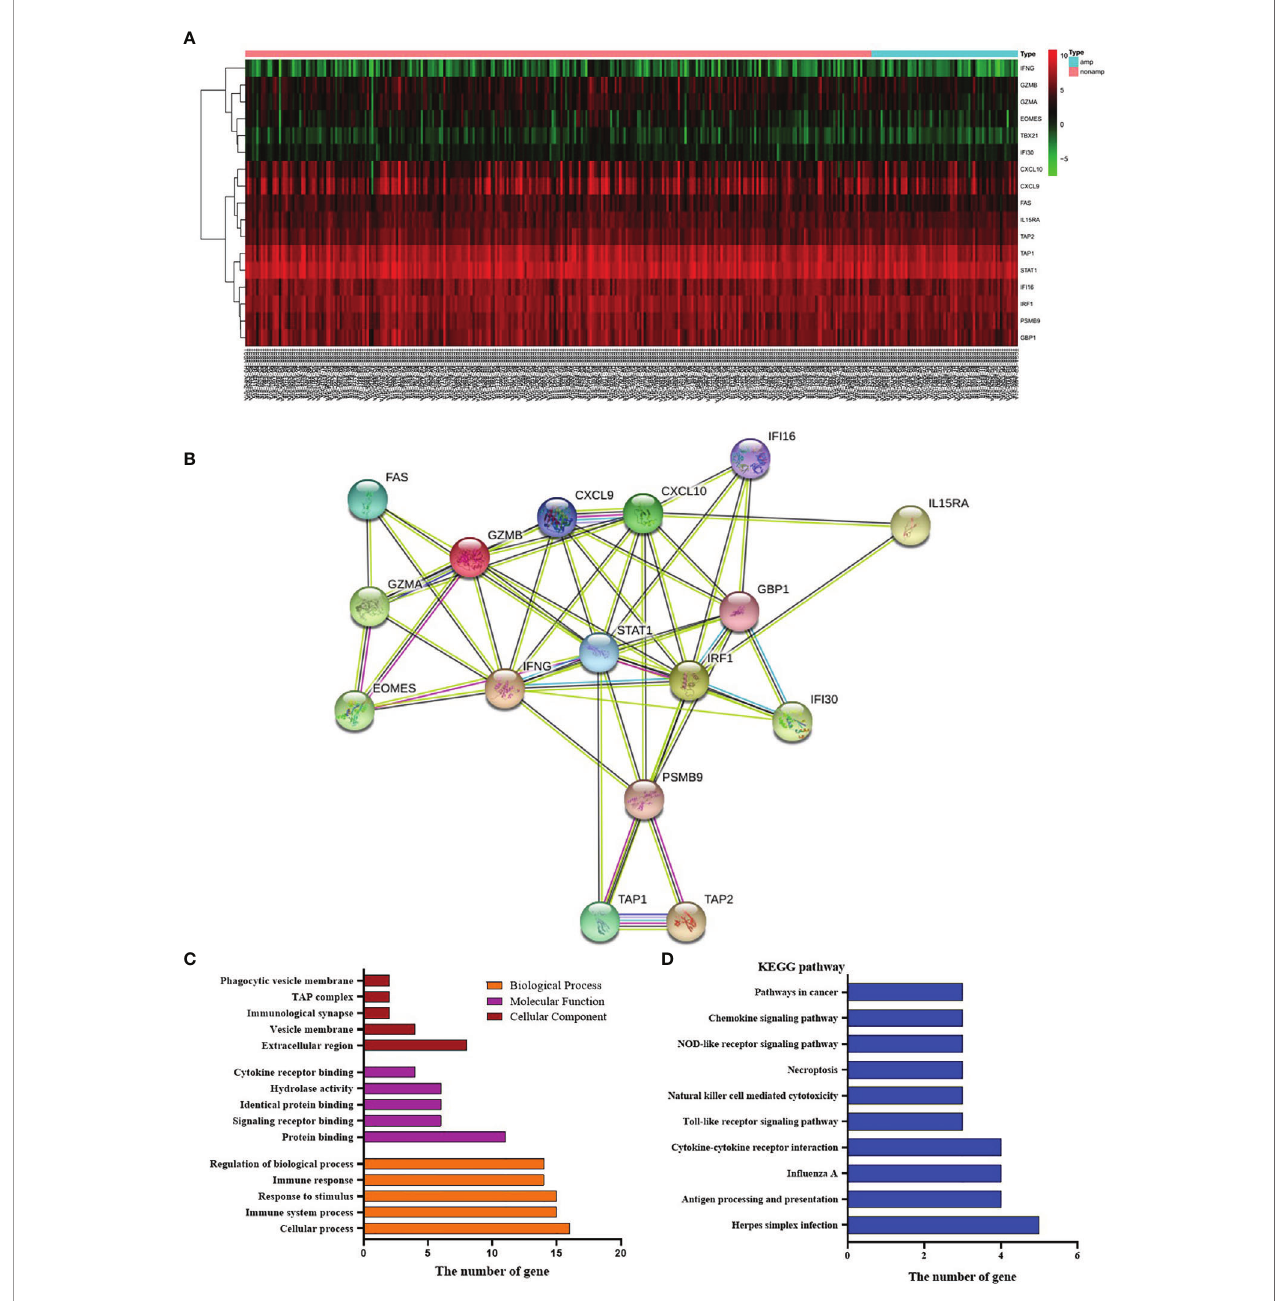
FIGURE 6 | Effects of HER-2 status and cytokines. (A) The heat map of cytokines in GC. (B) Interaction mapping of different gene in HER-2 Amp and non-amp group. (C) Gene distribution based on GO analysis. (D) KEGG pathway analysis of differential